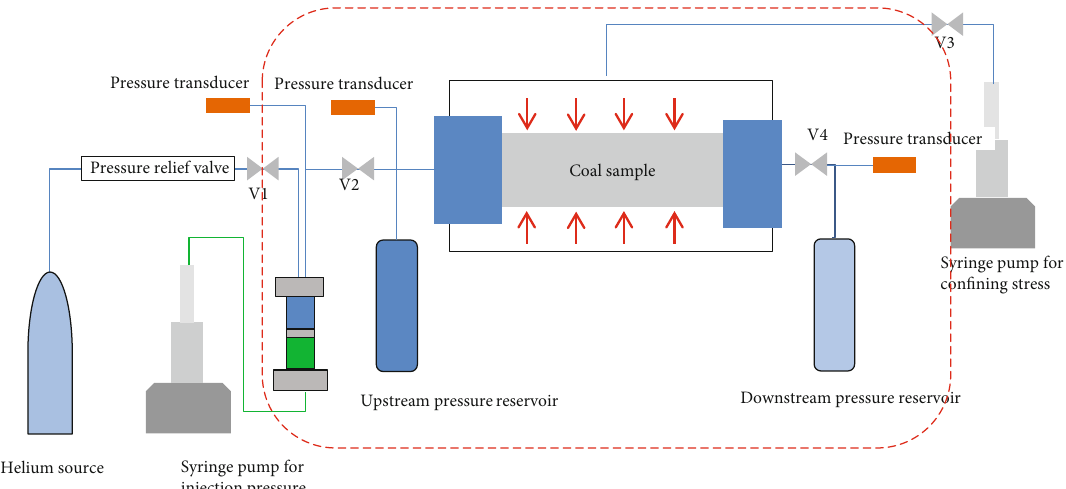
Figure 2: Schematic diagram of the experimental